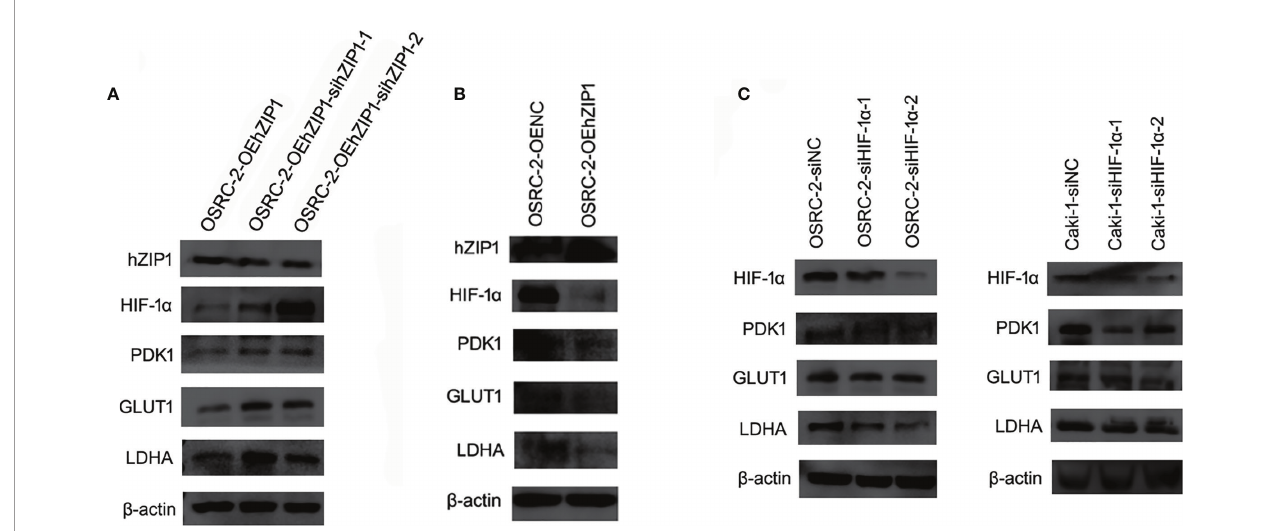
FIGURE 6 | Effect of hZIP1-siRNA and HIF-1 a -siRNA on renal cancer cells. (A) First, the siRNA knockdown ef fi ciency on the OSRC-2-OEhZIP1 cells was analyzed by western blot (P <0.01). Western blot results also indicated that HIF-1 a , PDK1, GLUT1 and LDHA expression signi fi cantly declined after loss of hZIP1 (P <0.05). (B) Second, hZIP expressing plasmid was selected to increase hZIP1 expression. PDK1, GLUT1, and LDHA protein levels were decreased upon hZIP1 overexpression (P <0.05). (C) Third, HIF-1 a -siRNA was selected to downregulate HIF-1 a expression. PDK1, GLUT1, and LDHA protein levels were decreased upon HIF-1 a downregulation (P